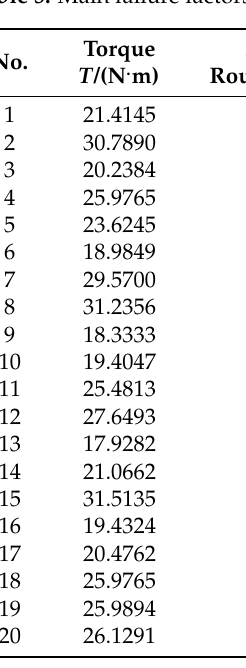
Table 5. Main failure factors of assembled camshaft (output value of BP neural